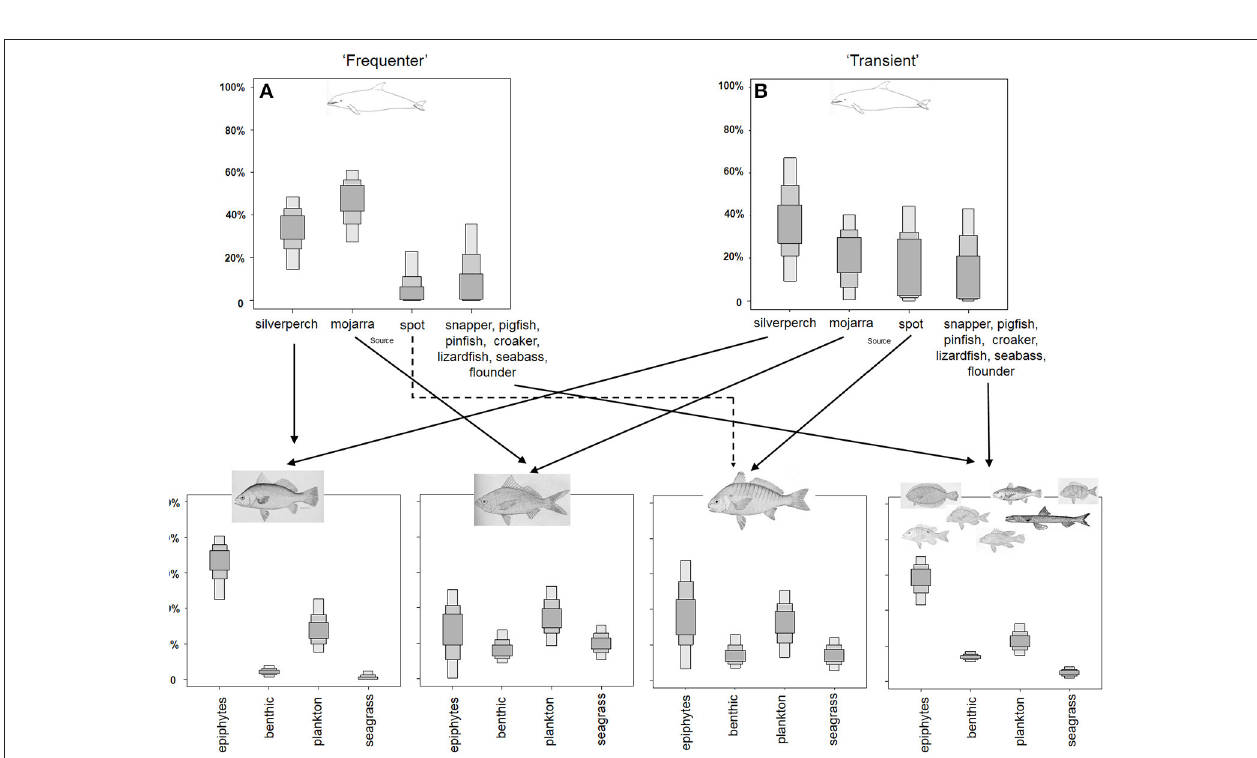
FIGURE 4 | Diagram of the St. George Sound foodweb leading to HSF (A) and LSF (B) bottlenose dolphins based on the nested MixSIAR modeling results. MixSIAR modeling results of relative diet and source contributions were used to inform linkages between dolphins, their prey, and the ultimate primary producers that supported those prey species. Boxes outline the 25, 75, and 95% credibility intervals of relative contributions. Fish images incorporated into this figure were obtained from WikiCommons and the Freshwater and Marine Image Bank and are in the public